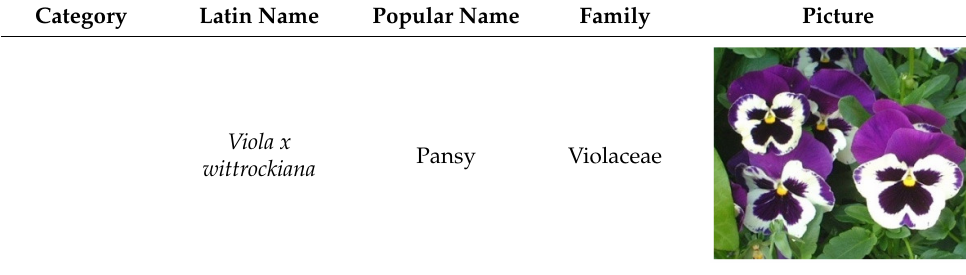
Figure sources: https://www.flower-db.com/ and http://tropical.theferns.info/.